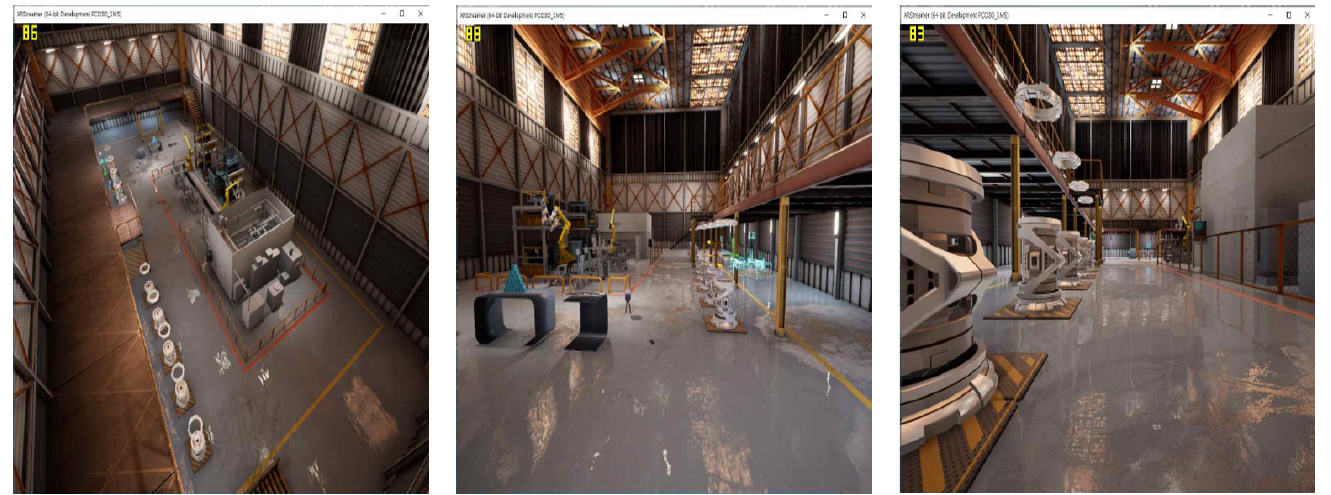
Figure 19. Frame rendering